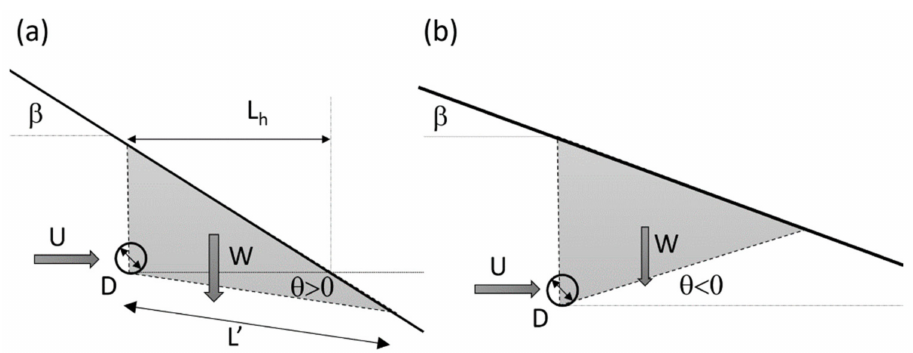
Figure 3. Simplified failure mechanism ( a ) case θ > 0, ( b ) case θ < 0. W ⊥ = W cos θ and W (cid:107) = W sin θ are the components of the soil weight nor- β / ( tan ( β ) − tan ( θ ) ) , and the water thrust is horizontal with a magnitude U = D γ w H . 0.5 γ L 2 h